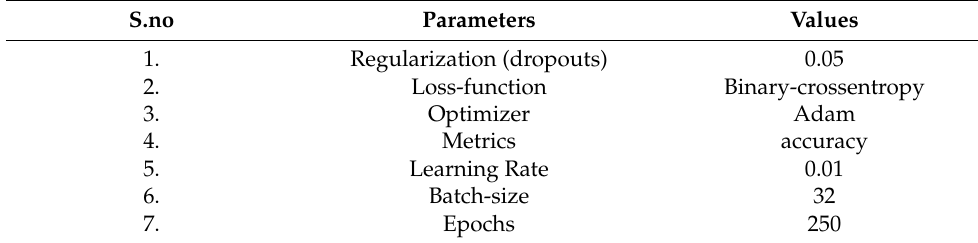
Table 8. Optimized Parameters used for